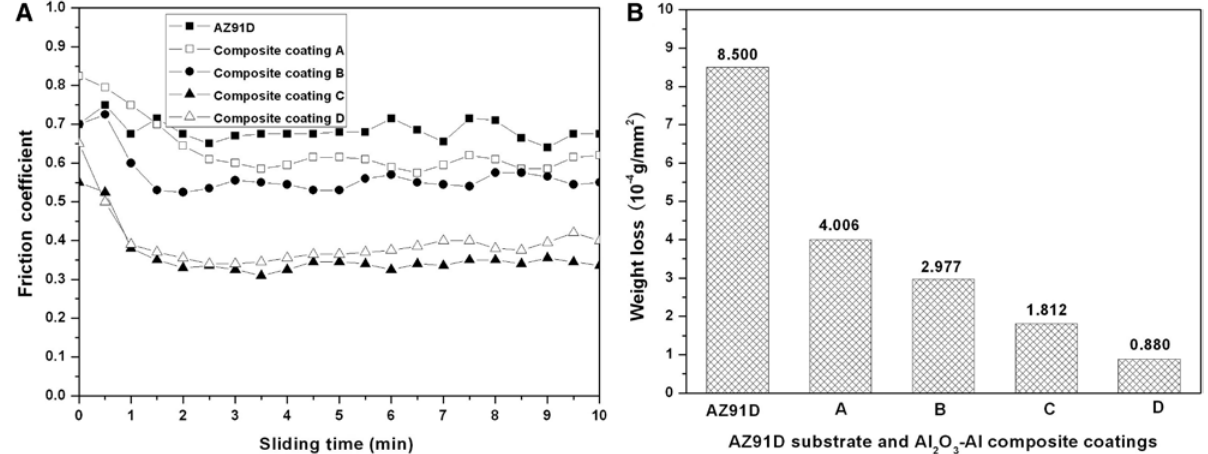
O -Al composite 2 3